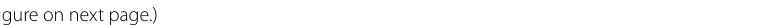
(See figure on next page.) Fig. 8 Tetrandrine prevents OVX-induced bone loss in vivo. A Weight change diagram of mice after Tetrandrine treatment (each; n OPG, TNFα and IL-6 levels in serum of mice were determined with Elisa assay. C , D Detection of the tetrandrine effects on the expression of TRAIL in the OVX-induced model carried out with RT-qPCR and western blot. E Detection of NFATc1, DC-STAMP, TRAP and CTSK expression levels was carried out with RT-qPCR. F Calcein-alizarin red S labeling to detect the femur mineral apposition rate (MAR) in mice. G TRAP staining was used for sections of femurs and number of osteoclasts per field of each specimen were measured. H The Von kossa staining was used for the sections of femurs and the MS/BS (%) was measured. All experiments were carried out in triplicate. The results were presented as mean *** P < 0.005 and **** P < 0.001 as compared with the control